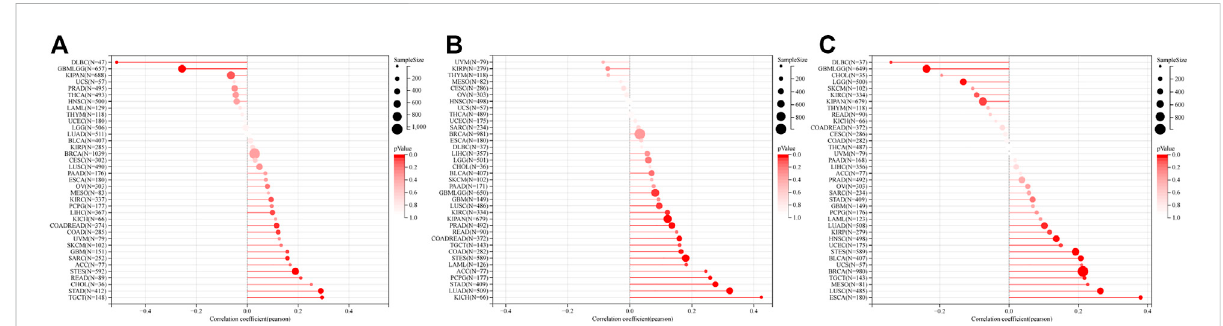
FIGURE 11 MSI, TMB, and tumor heterogeneity correlation analysis of RAD51AP1 in pan-cancer. (A) MSI. Positively correlated in COAD ( p = 0.041), COADREAD ( p = 0.026), STES ( p < 0.001), SARC ( p = 0.012), STAD ( p < 0.001), READ ( p = 0.048) and TGCT ( p < 0.001). Negatively correlated in GBMLGG( p < 0.001)and DLBC ( p < 0.001). (B) TMB. Positively correlated in14 cancer types includingGBMLGG( p= 0.037),LUAD ( p < 0.001), COAD ( p= 0.005),COADREAD( p= 0.002),LAML( p= 0.044),STES( p < 0.001),KIPAN( p= 0.001),STAD( p < 0.001),PRAD( p= 0.003),KIRC( p= 0.027), LUSC ( p = 0.037), PCPG ( p < 0.001), ACC ( p = 0.032) and KICH ( p < 0.001). (C) MATH. Positively correlated in LUAD ( p = 0.021), BRCA ( p < 0.001), ESCA( p < 0.001), STES ( p < 0.001), UCEC ( p = 0.049), HNSC( p = 0.002), LUSC( p < 0.001), MESO( p = 0.041), TGCT ( p = 0.009) and BLCA ( p < 0.001). Negatively correlated in GBMLGG ( p < 0.001), LGG ( p = 0.003), KIPAN ( p = 0.049) and DLBC ( p = 0.039).